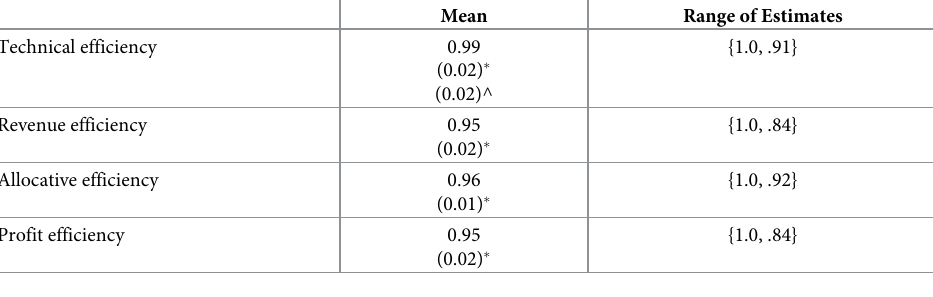
Table 4. Summary bull efficiency estimates from free disposal hull analysis (fat, protein, somatic cell count, live- ability, udder composition, and daughter pregnancy rate and calving ability as outputs, semen as sole input).